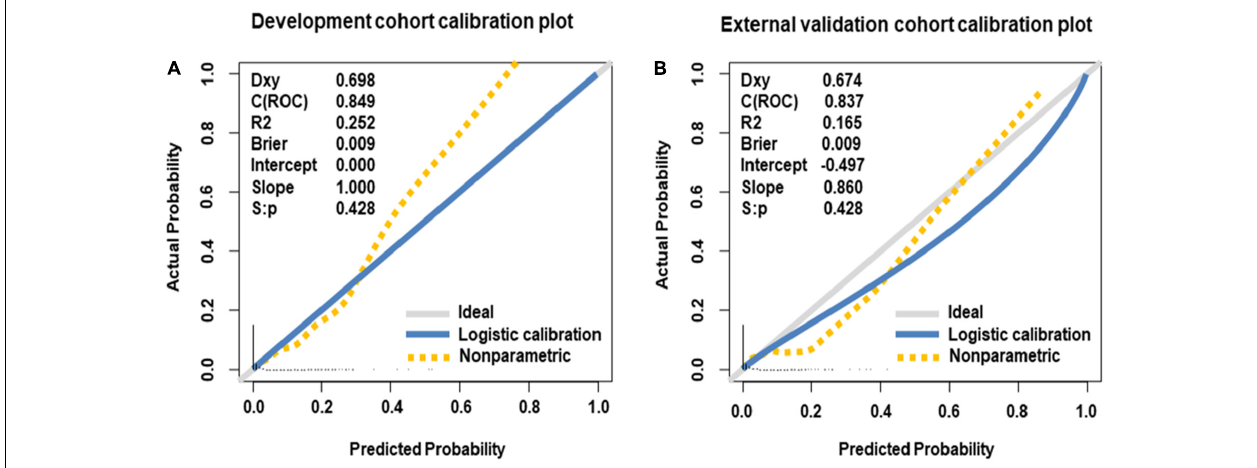
FIGURE 5 | Calibration curves of nomogram for predicting offspring congenital heart disease, in the development cohort (A) and the external validation cohort (B) . The 45-degree long gray solid line represents an ideal prediction, and the blue solid line represents the predictive performance of the nomogram. The closer the blue solid line is to the ideal line, the better the predictive performance of the nomogram